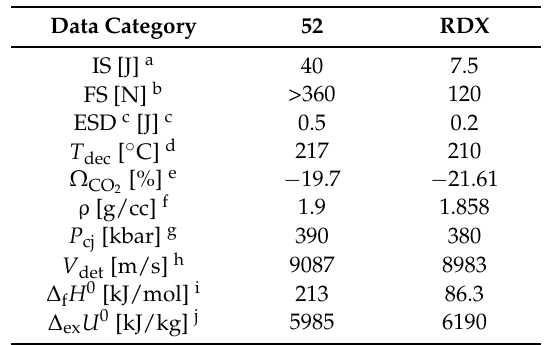
Table 7. Sensitivities and performance of Dihydroxylammonium salt 52 and RDX. Data